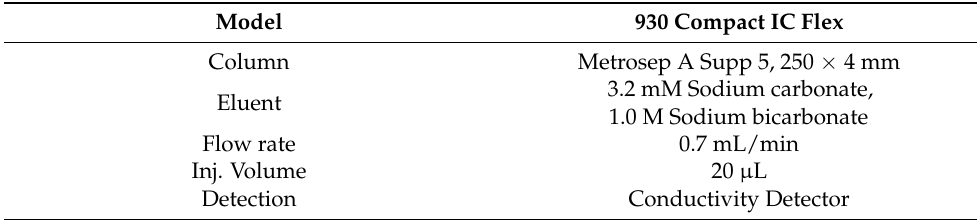
Table 4. The conditions of chromatographic ionic analysis.